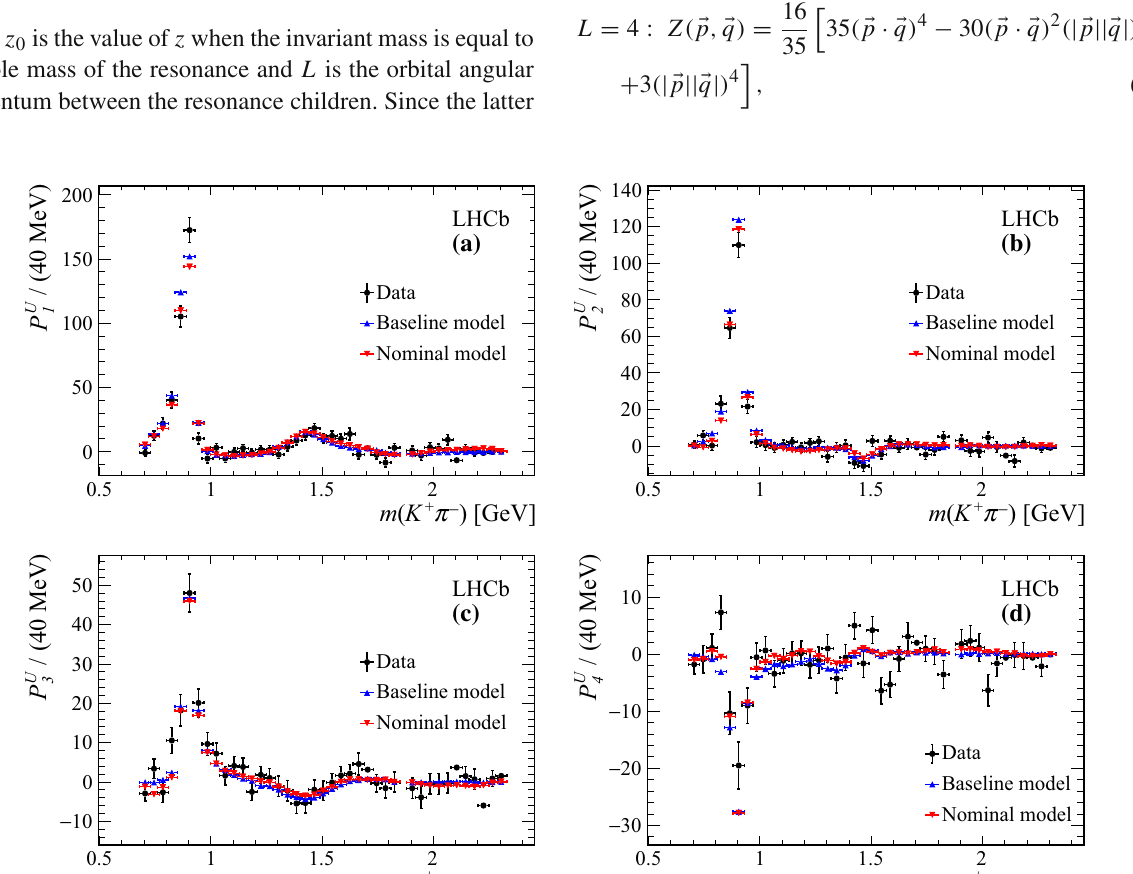
Fig. 10 Comparison of the first four K + π − Legendre moments determined from background-subtracted data (black points) and from the results of the amplitude fit using the baseline model (red triangles) and nominal model (blue triangles) as a function of m ( K + π −